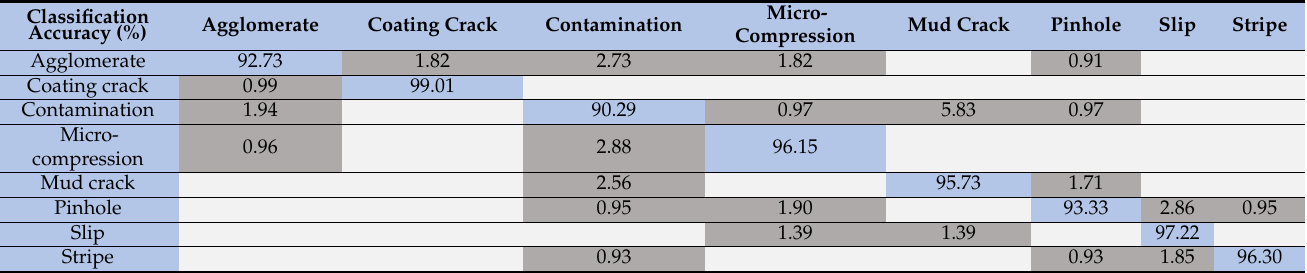
Table 3. Reclassification accuracy of taught defects (lines) by machine learning algorithm (columns) with selected defect features (lines add up to